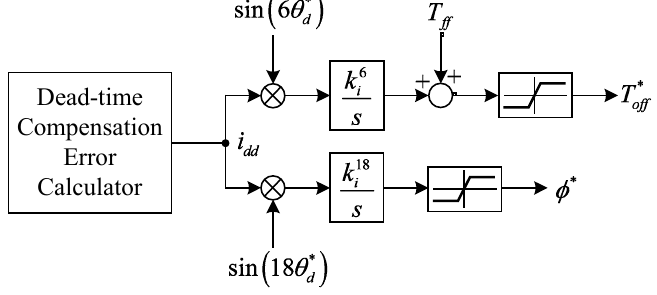
Figure 12. Proposed on-line TCV controller scheme.